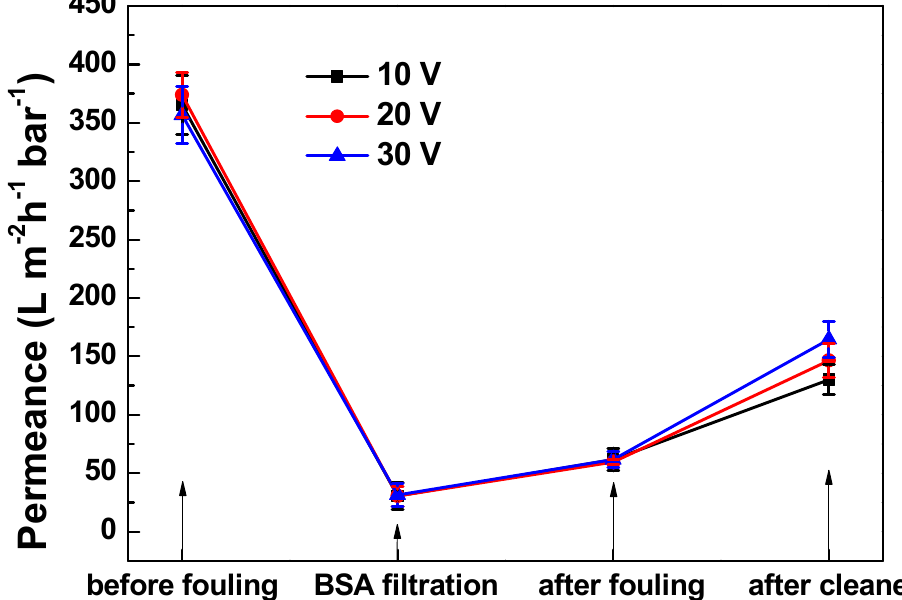
Figure 7. Permeance of PANI/EG composite membranes (virgin, BSA fouled, after fouled and cleaned) at different applied potentials. Experimental conditions: applied potential 10–30 V, operating pressure 2 bar, [BSA] = 1.0 g L –1 , room temperature.